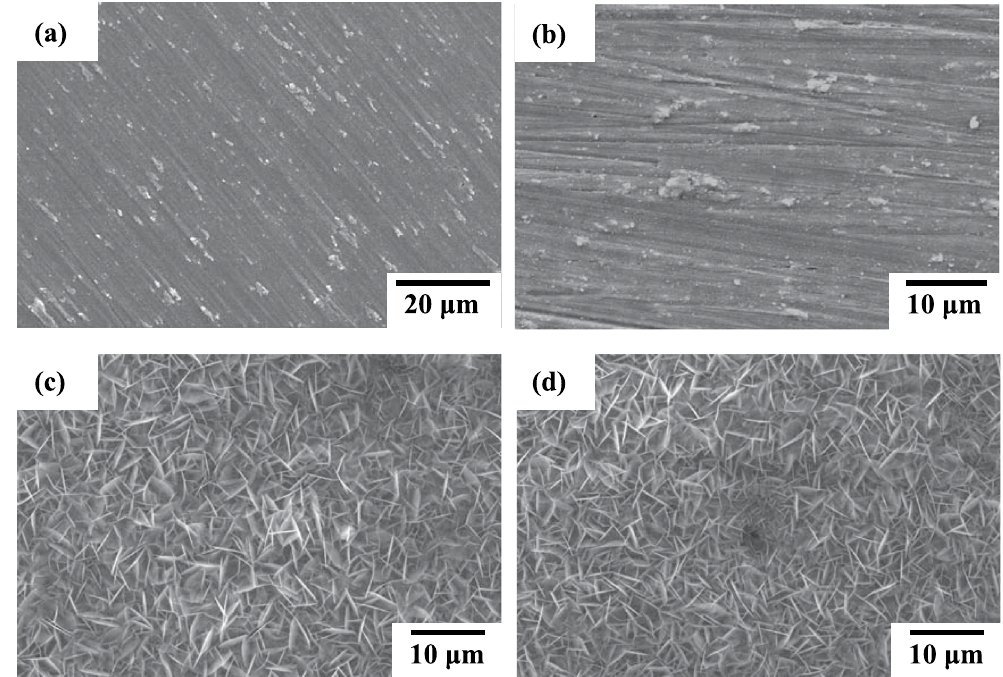
Figure 1. SEM surface morphologies of the ( a ) polished AZ61 Mg alloy, ( b ) alkaline pre-treated AZ61-AP, ( c ) hydrothermally treated AP-HT, and ( d ) T-BAG surface treated HT-SAM